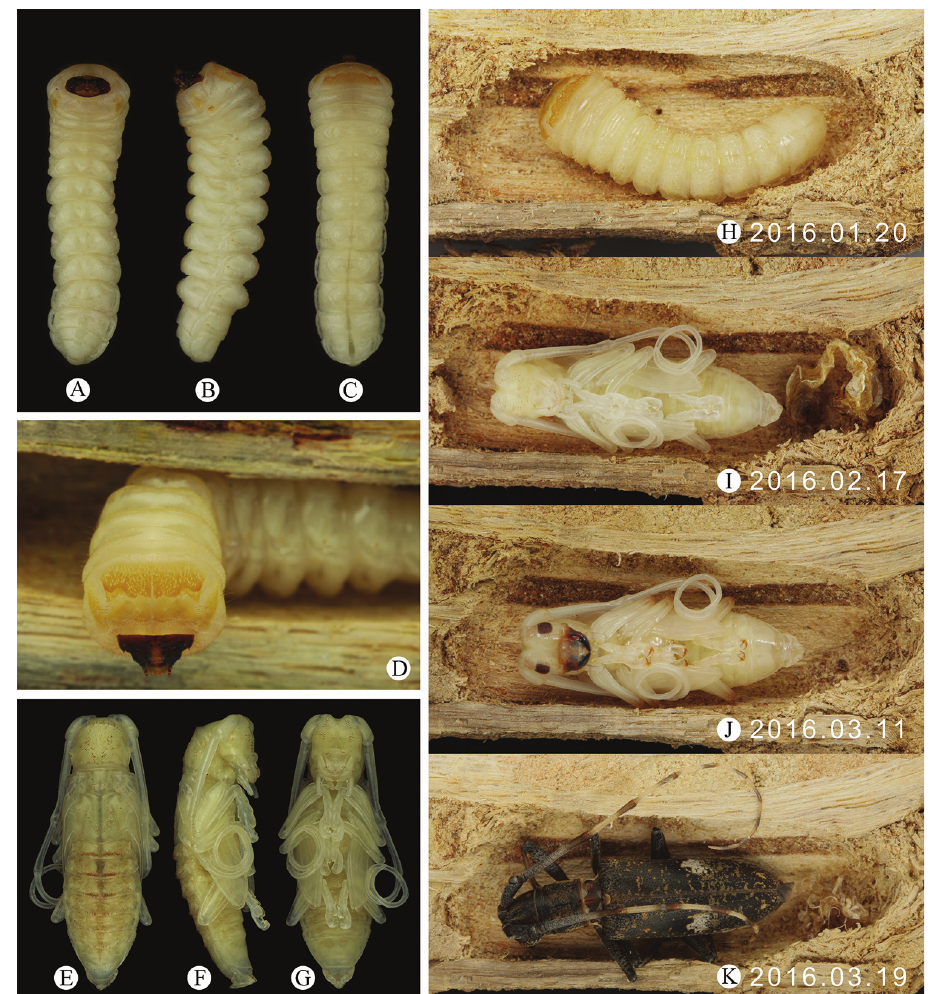
Figure 5. Pseudomacrochenus wusuae sp. n. (paratypes). A–D last instar larva ( A ventral view B ventro- lateral view C dorsal view D front view) E–G pupa ( E dorsal view F lateral view G ventral view) H last instar larva in pupal chamber (20.I.2016) I pupa in pupal chamber (17.II.2016) J pupa in pupal chamber (11.III.2016) K newly sclerotized adult in pupal chamber